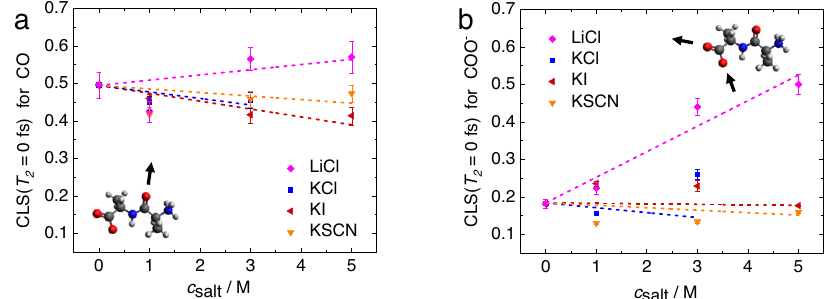
Fig. 8 Spectral heterogeneity is salt-speci fi c for the COO − mode but not for the amide CO. Center line slope at 0 fs waiting time for a the amide CO and b the anti-symmetric COO − stretching mode. Symbols show experimental data, dashed lines are a visual aid. Error bars correspond to the standard deviation of the CLS of the bleaching signal determined from fi ve different 5 M KSCN (Fig. 7i, j) qualitatively resemble the spectra for 2Ala